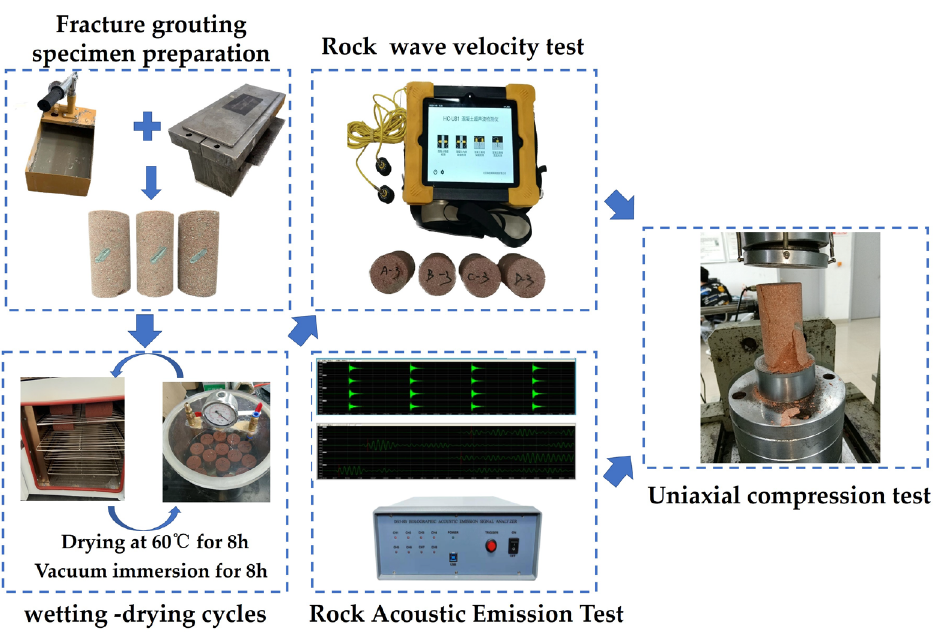
Figure 2. Test flowchart.